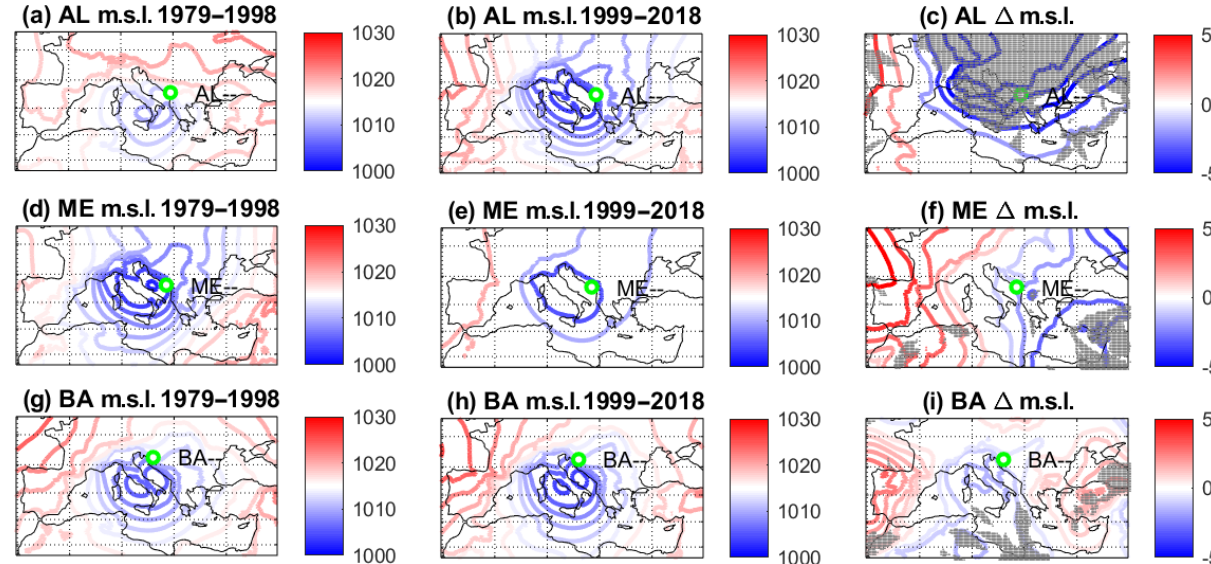
Figure 9. Average of sea-level pressure (m.s.l.) fields (hPa) during days of yearly maximum snowfall for the periods 1979–1998 (a, d, g) and 1999–2018 (b, e, h) . Panels (c) , (f) and (i) show the differences between the second and the first periods (cid:49) m.s.l.. (a, b, c) Albania (AL), (d, e, f) Montenegro (ME), (g, h, i) Bosnia (BA). Green circles show the location of the northwesternmost point of each country. Shaded areas represent grid points where at least two-thirds of the anomalies have the same